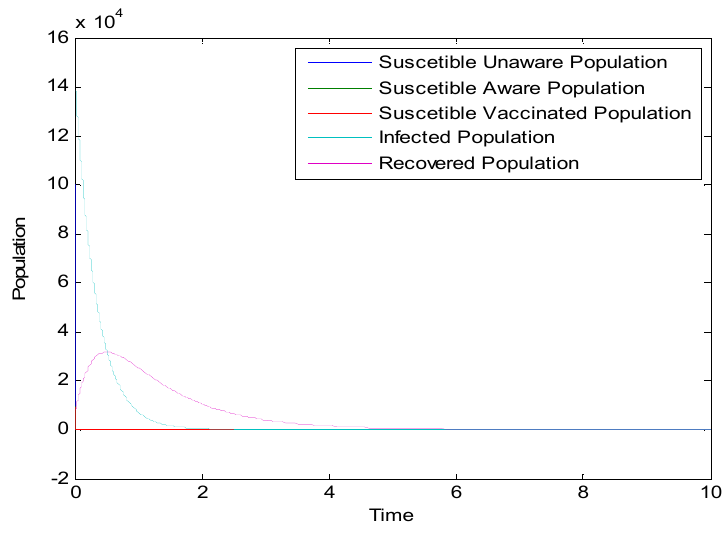
Figure 1. Dynamics of the model.